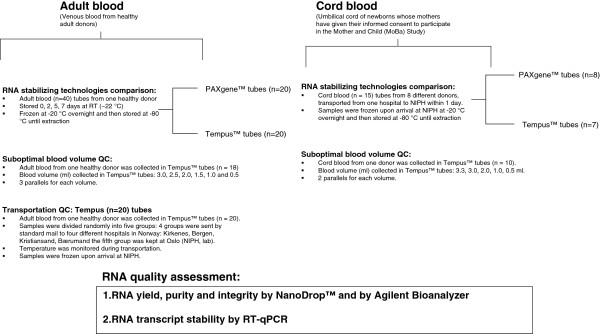
Flow chart: experimental design.